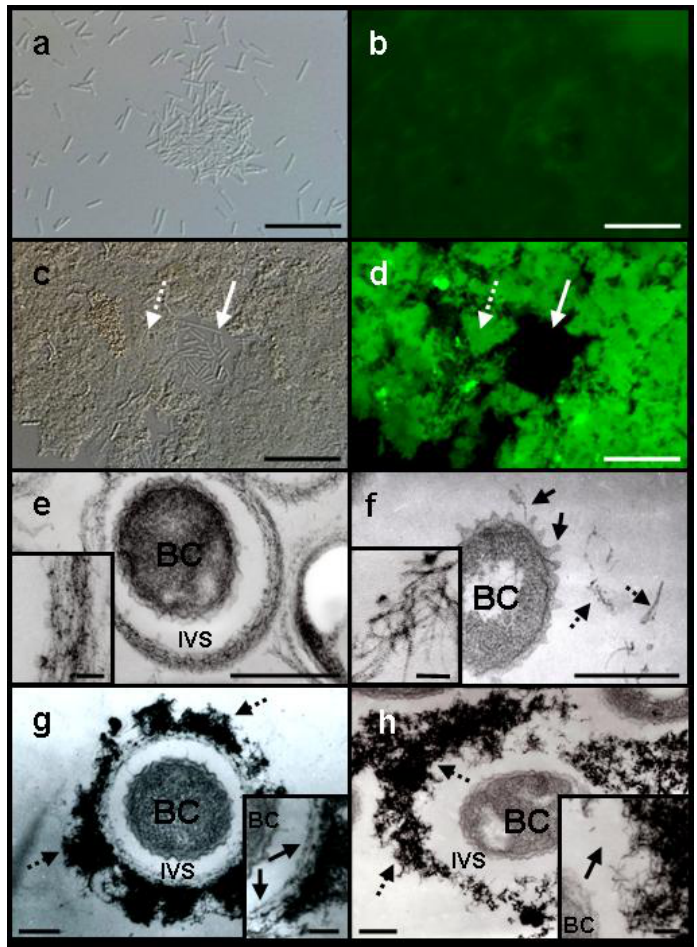
Figure 2. DIC light ( a and c ) and fluorescence ( b and d ) microscopy of Leptothrix sp. strain OUMS1 or sheathless mutant (SL) cultured in –Fe or +Fe medium and treated with FITC-conjugated PHA-E lectin and TEM images of cells and associated structures ( e – h ). ( a ) Free, loosely gathered chained cells of SL grown in –Fe medium; and ( b ) their weakly positive response to the lectin. Scale bar, 20 µm; ( c ), ( d ) Densely aggregated SL cells and associated structures (dotted arrow) and single free or short-chained cells (solid arrow) grown in +Fe medium and their intense fluorescence after lectin treatment. Scale bar, 20 µm; ( e ) OUMS1 cell (BC) in –Fe medium, surrounded by an immature sheath frame of parallel-arranged fibrils across the intervening space (IVS). Inset: enlarged image of parallel-arranged fibrils. Scale bars, 500 nm and 50 nm (inset); ( f ) SL cell in − Fe medium. Thread-like projections are on the cell surface (solid arrows), and excreted fibrils (dotted arrows) are scattered away from the cell. Inset: enlarged image of scattered fibrils. Scale bars, 500 nm and 50 nm (inset); ( g ) OUMS1 cell in +Fe medium, surrounded by a partitioned sheath across the IVS. Sheath was composed of inner layer and outer layer of heavy electron density (dotted arrows). Inset: enlarged image of inner layer (arrows). Scale bars, 250 nm and 100 nm (inset); ( h ) SL cell in +Fe medium, surrounded by heavily aggregated (dotted arrows) but not well-organized fibrils of extremely high electron density. Inset: enlarged image of irregularly clustered fibrils (arrow). Scale bars, 250 nm and 100 nm (inset). All images are of 3-day cultures, except for ( g ) (2-day